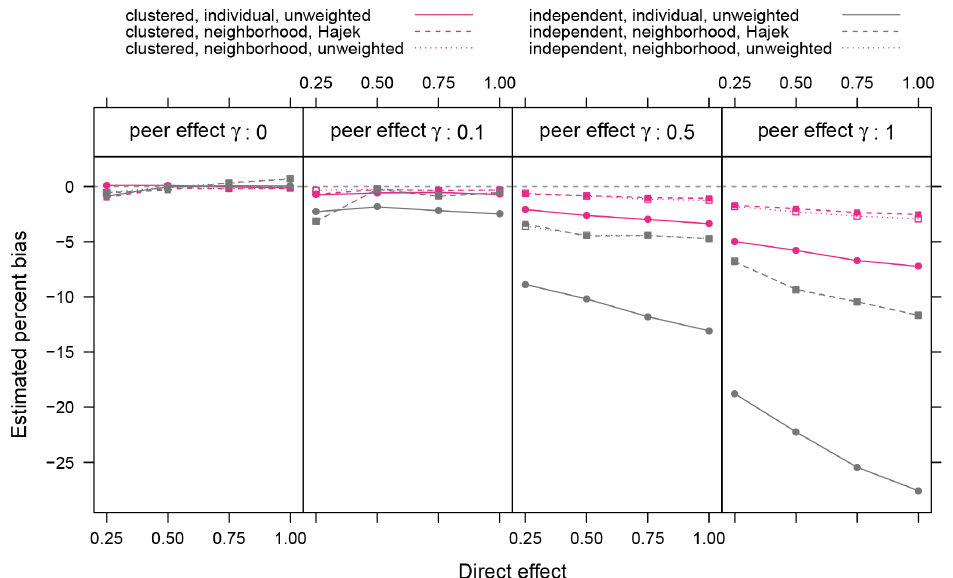
Figure 5 Relative bias in ATE estimates for different assignment procedures, exposure models, and estimation